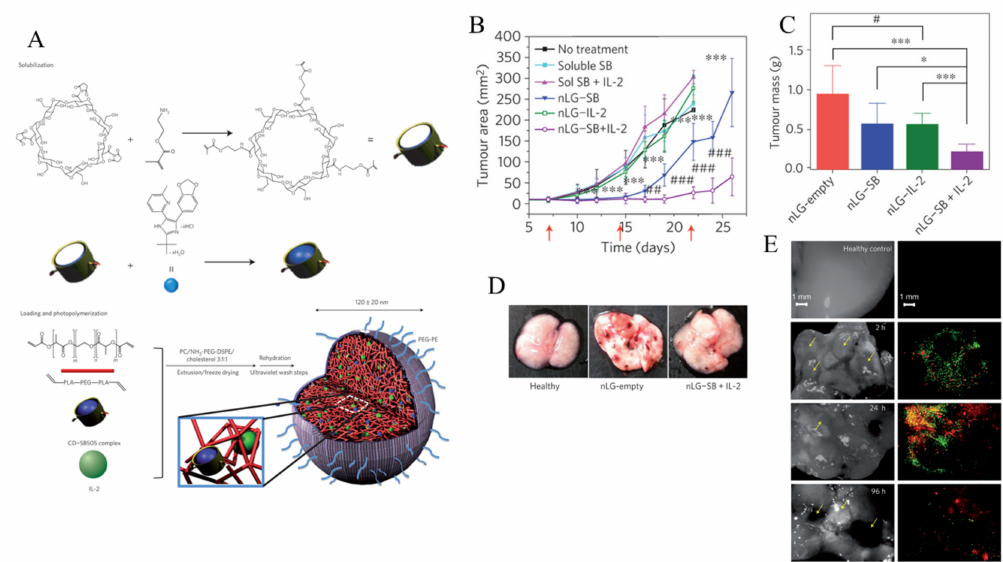
Figure4. ( A )Thesynthesisapproachoftheliposomalpolymericgel(nLG)particlesystem.( B )Plotoftumor area versus time. Red arrows indicate treatments (via intratumoral injection). ( p < 0.05, *, p < 0.001, ***, By ANOVA with Turkey’s multiple comparison test. p < 0.05, #, by two-tailed t-test. ( C ) Tumor masses vs nLG-treated groups, p < 0.001, ***, p < 0.01, **, p < 0.05, *, By ANOVA using Turkey’s post-test. ( D ) Images of lung immediately before collection of lung-infiltrating lymphocytes from mice, ( E ) Uptake of lipid carrier (green) and rhodamine payload (red) around individual lung tumors at 2 h post injection. Reproduced with permission from [107]. Copyright 2012, Nature Publishing